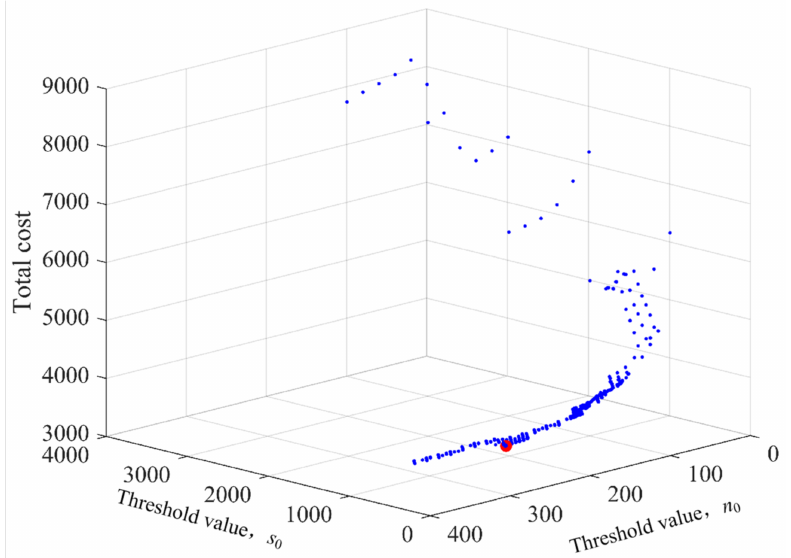
Figure 6. Diagram showing how to select the threshold. The red point corresponds to the best threshold with lowest construction